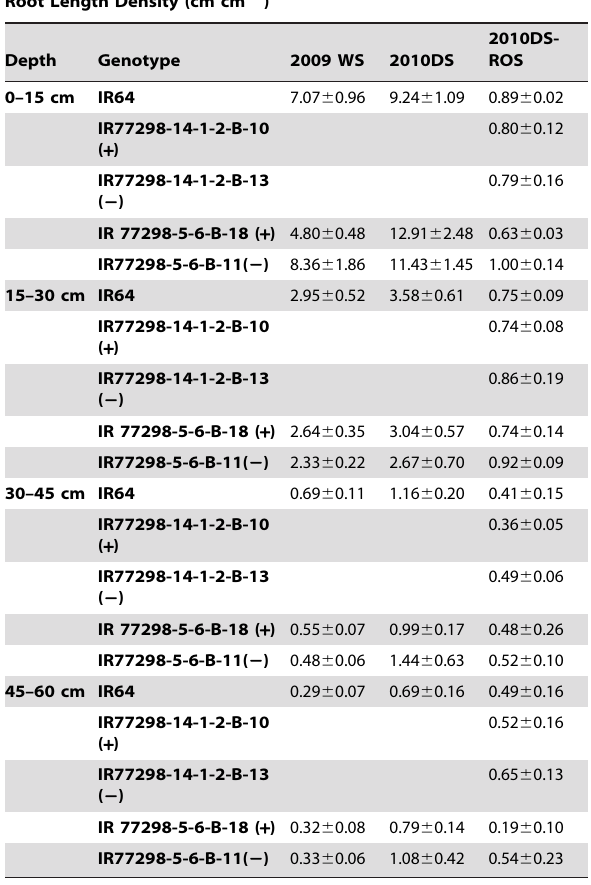
Table 2. Root length density of + QTL lines, 2 QTL lines, and IR64 at different depths in field drought studies, as sampled with a 4-cm diameter corer tube placed mid-way between hills of adjacent